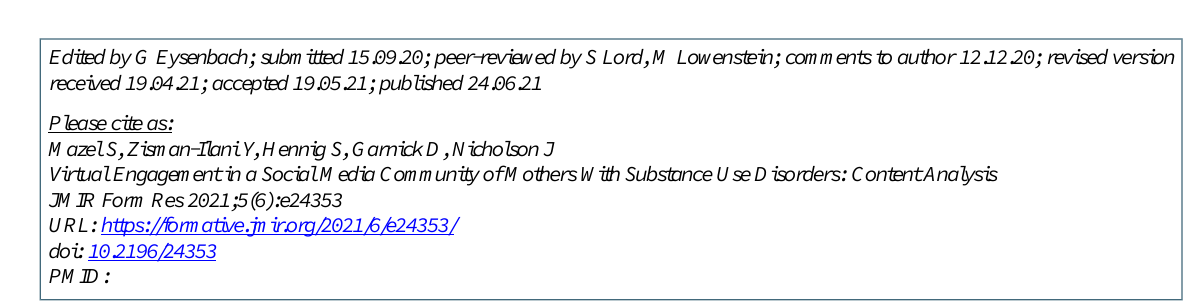
and reproduction in any medium, provided the original work, first published in JMIR Formative Research, is properly cited. The complete bibliographic information, a link to the original publication on https://formative.jmir.org, as well as this copyright and license information must be